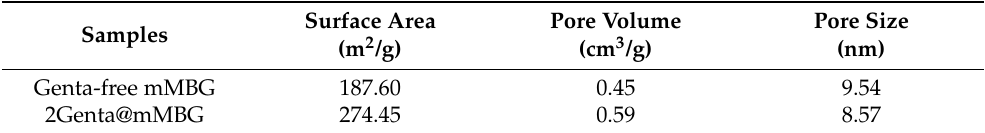
Table 2. Analysis of specific surface area, pore volume, and pore size of Genta-free mMBG